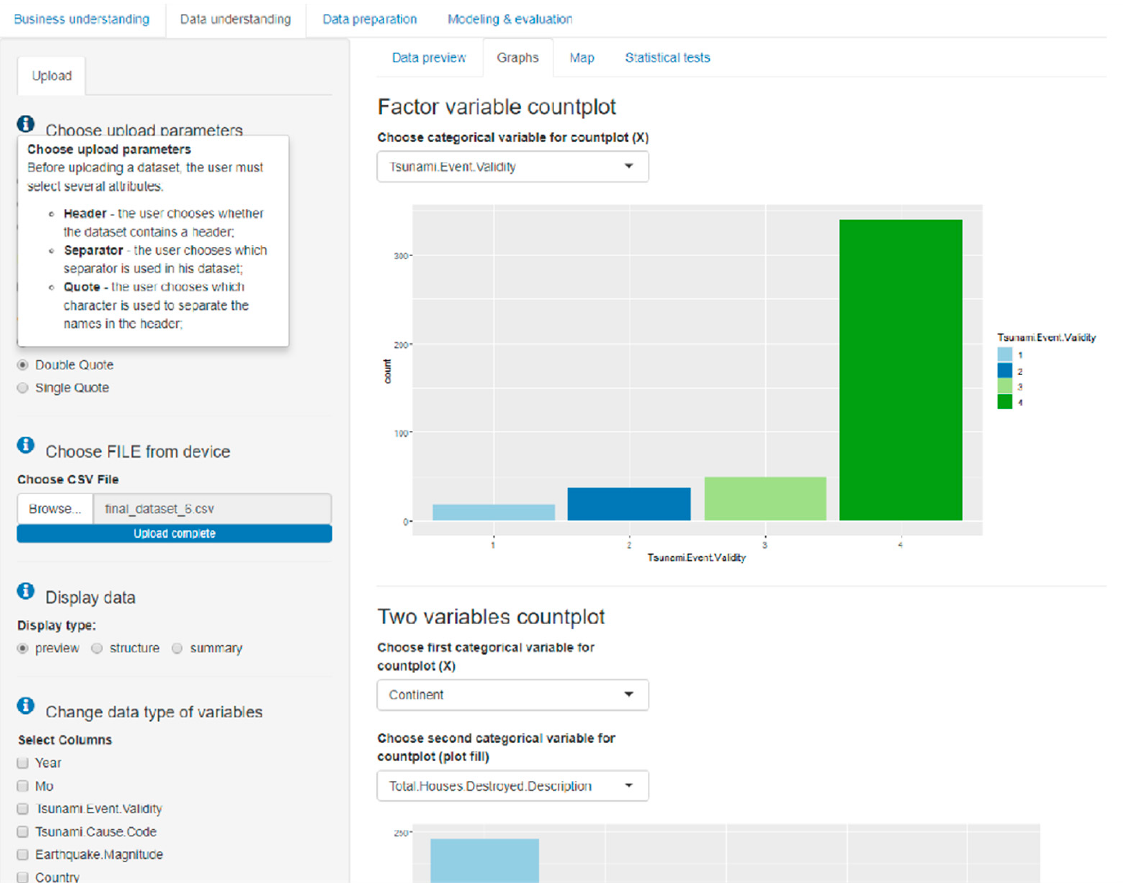
Figure 8. Algorithms/parameters settings, interpretability of a model (modelling and evaluation).